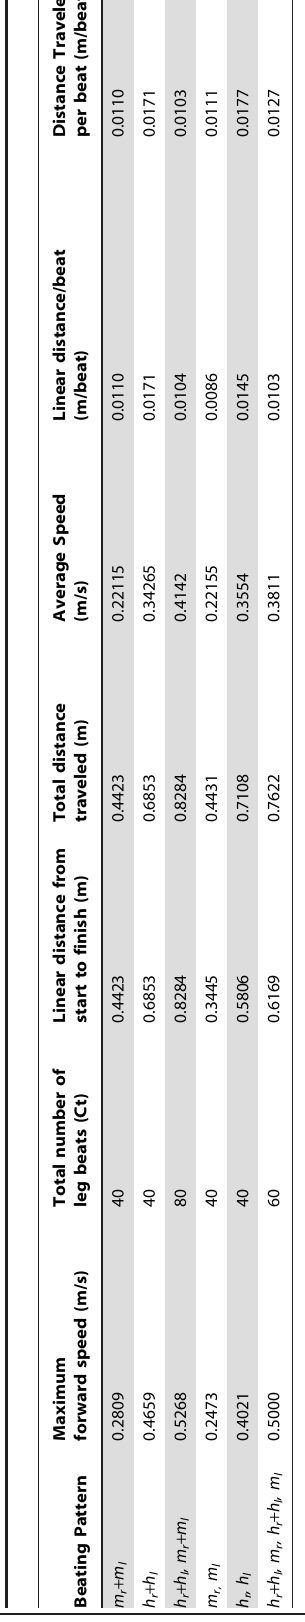
Figure 6 and the values calculated from these trajectories are shown in Table 4 . Based on the results obtained from